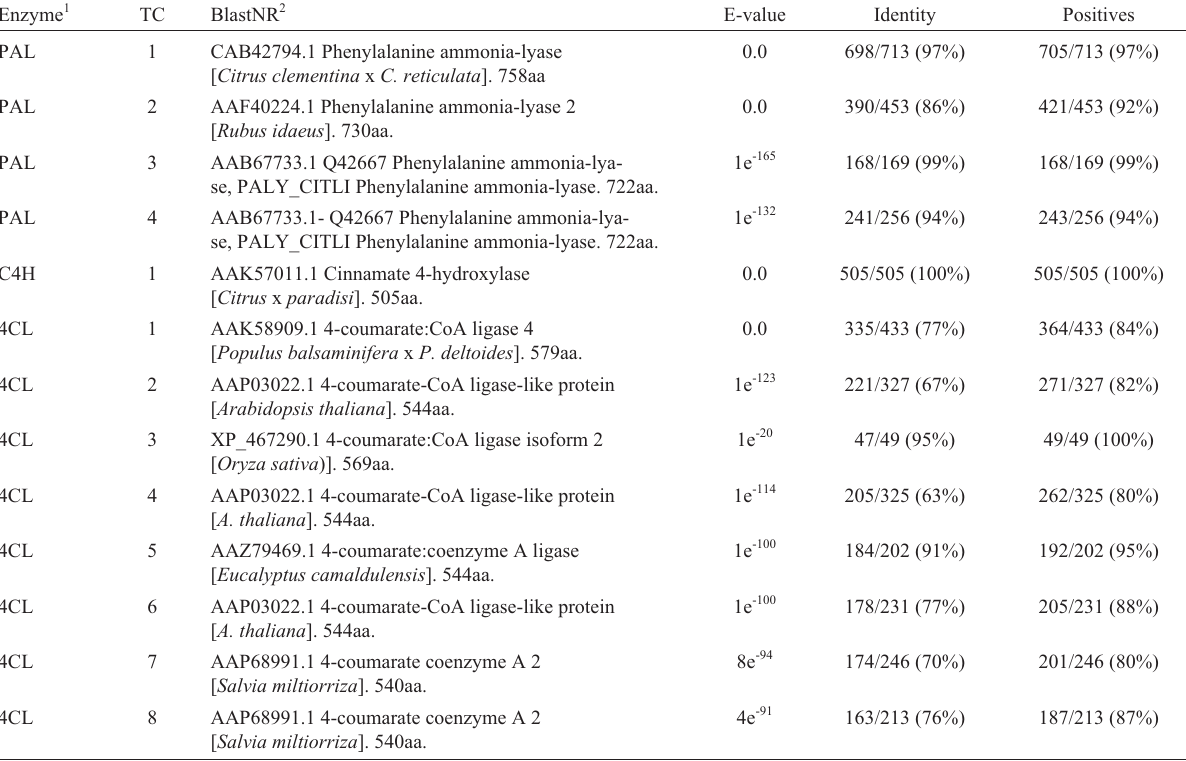
Table1 -Aflavonoidoverviewin Citrussinensis :CitESTtentativeconsensi(TCs)identitiesandcomparativeparametersagainstinternationaldatabases (Blast NR). Enzyme